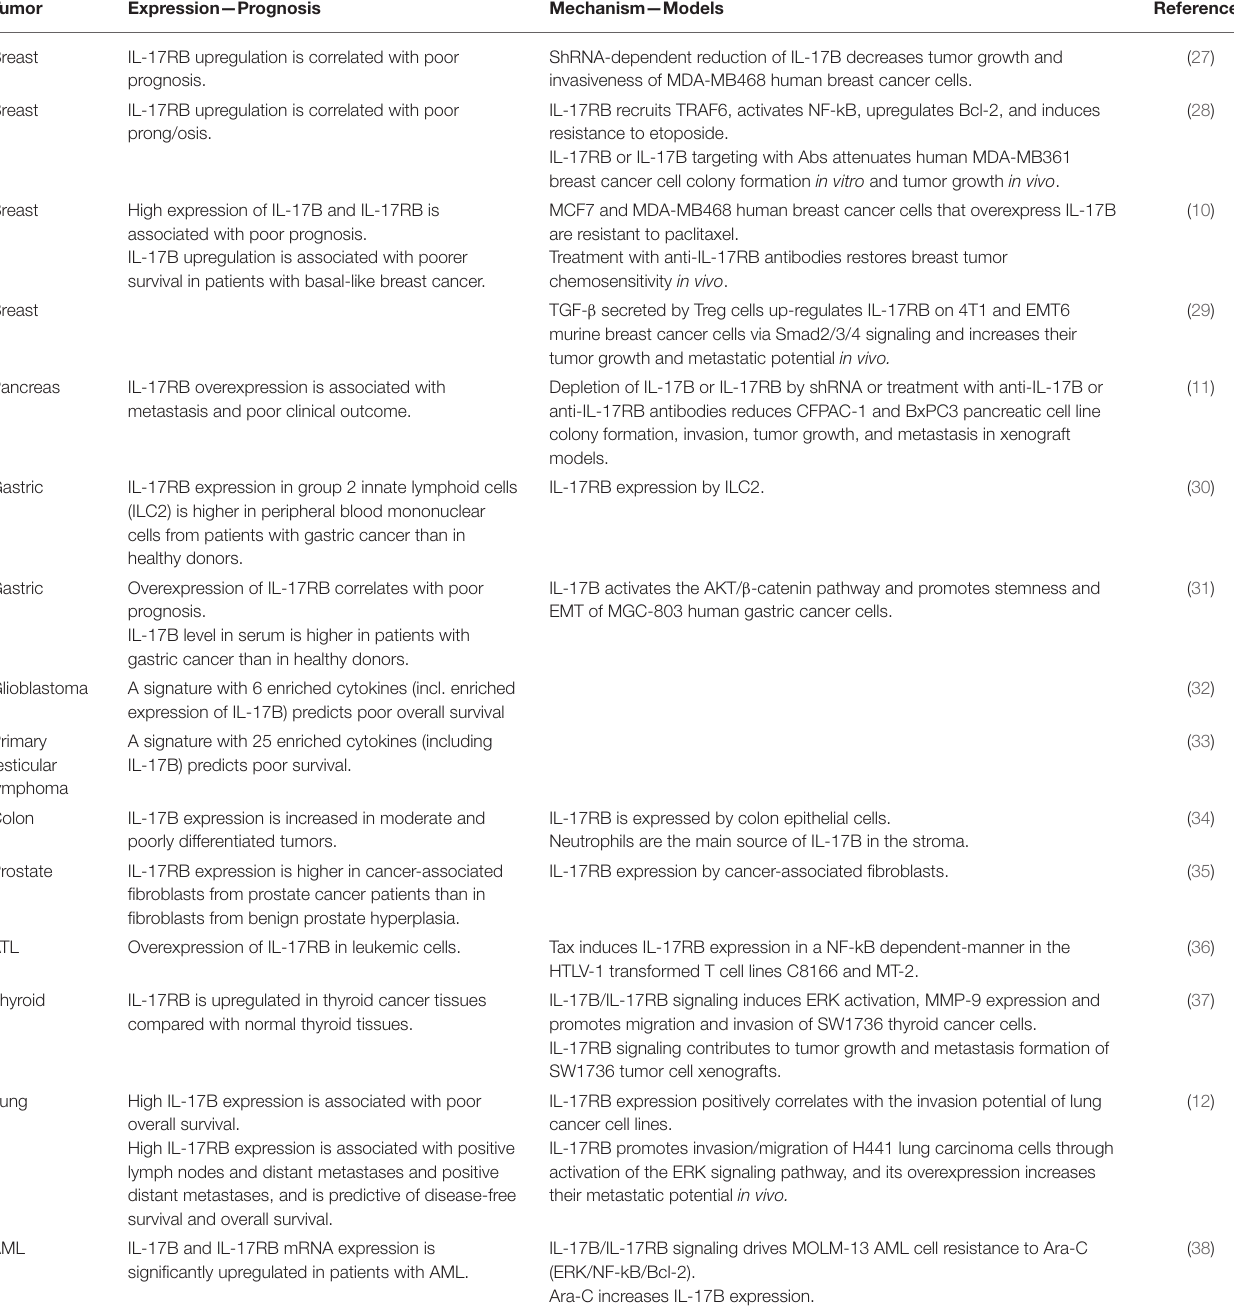
TABLE 1 | IL-17B IL-17RB expression in